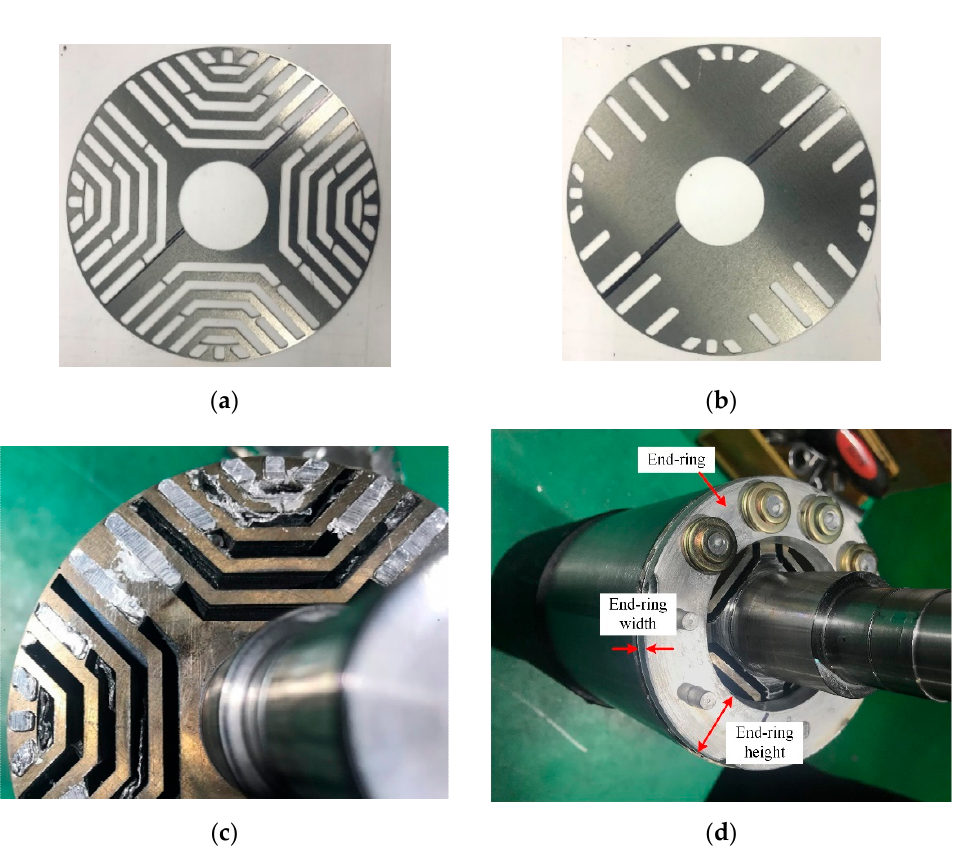
Figure 14. Manufactured LS-SynRM ( a ) rotor core, ( b ) endplate for die-casting, ( c ) cross-section of rotor, ( d ) rotor with the end-ring.